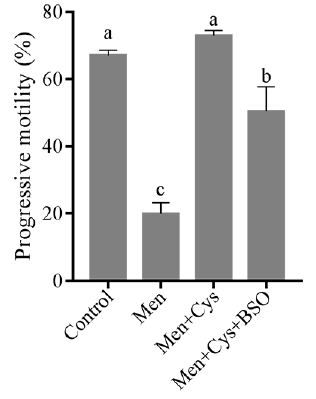
Figure 7. Effect of cysteine on sperm progressive motility in the me- nadione-induced ROS stress model. Data are the mean±standard de - viation (SD). a-c Columns with different lowercase letters differ signifi - cantly